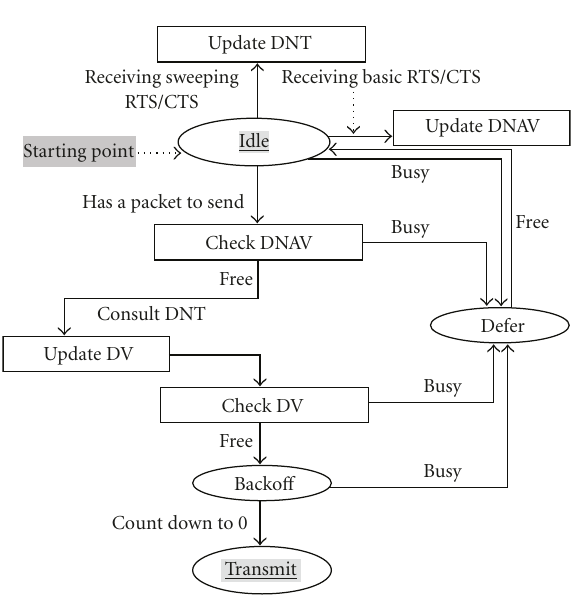
Figure 12: DNT and DV flowchart.